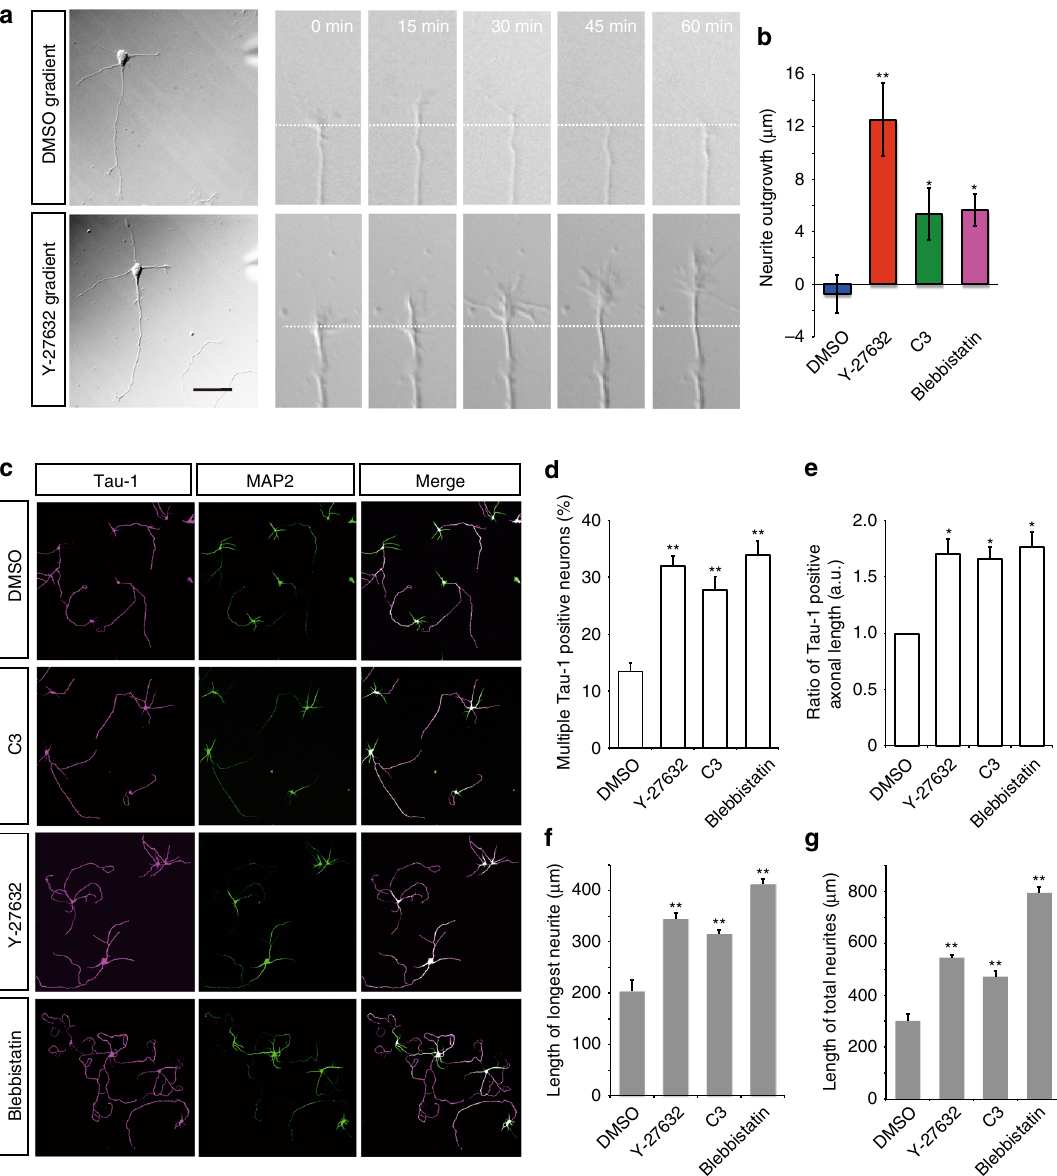
Fig. 5 RhoA/Rho-kinase was required for the maintenance of neuronal polarity. a Local inhibition of Rho-kinase induced minor neurite elongation. DMSO ( top ) or Rho-kinase inhibitor (Y-27632) ( bottom ) was locally applied to a minor neurite of a polarized hippocampal neuron. b Local application of Y-27632, C3 or Blebbistatin to a minor neurite. Minor neurite outgrowth was measured (Cont = 17, Y-27632 = 14, C3 = 13, Blebbistatin = 7 neurons from three independent experiments). c The effect of the RhoA/Rho-kinase signaling pathway on neuronal polarization. Hippocampal neurons at 3 DIV were treated with Y-27632, C3 or lebbistatin for 48 h. Neurons were co-immunostained at 5 DIV with anti – Tau-1 ( magenta ) and anti – MAP2 ( green ) antibodies. Representative images of neurons are shown. Scale bar, 100 μ m. d The percentages of neurons with multiple Tau-1-positive axons. e Bar graphs indicate the ratio of multiple axonal lengths. f , g The lengths of the longest neurite f and the total neurites g were determined (Cont = 91, Y-27632 = 90, C3 = 90, Blebbistatin = 91 neurons from three independent experiments). Error bars represent SEM. * P < 0.05 and ** P <